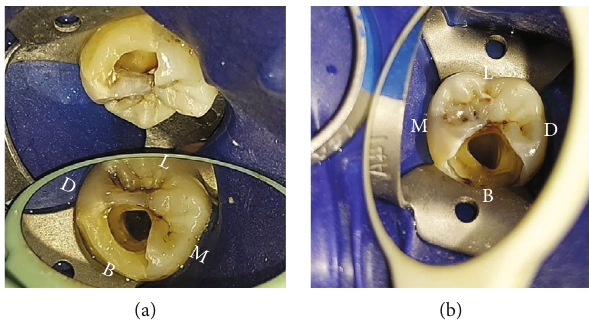
Figure 4: (a, b) Access openings of #36 and #46 showing the presence of a single